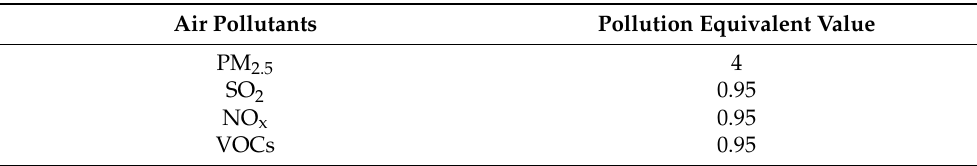
Table 4. Air pollutant pollution equivalent values [43].